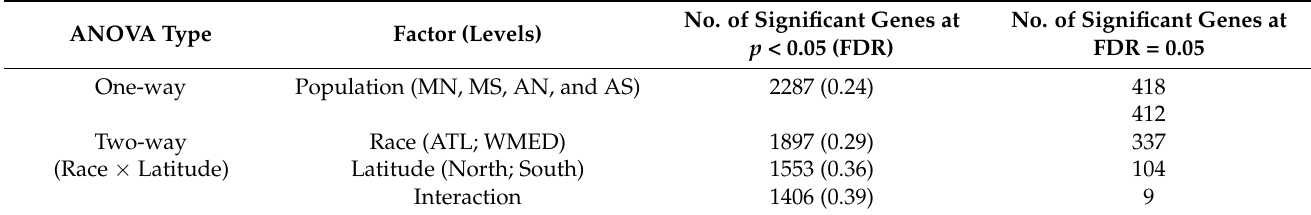
Table 1. Results of ANOVA on gene expression across clam populations. FDR: false discovery